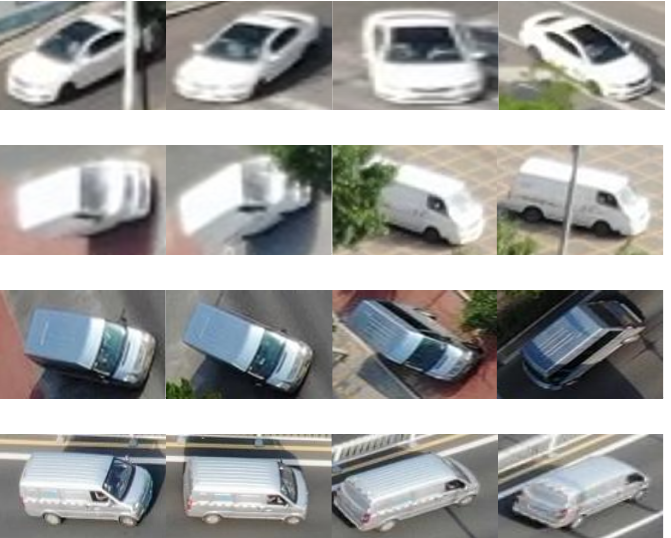
Figure 6. Details of our dataset.